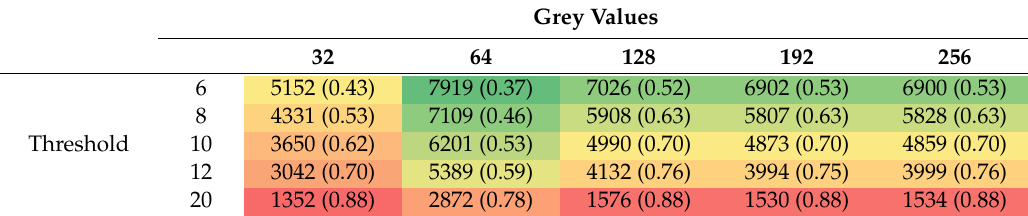
Table 3. Number of matching stones between the automatic and manual detection methods under di ff erent frame conditions at a bu ff er size of 3.00 m. Color scale indicates high values in green and low values in red. The proportion to the total number of automatically detected stones are in parentheses.